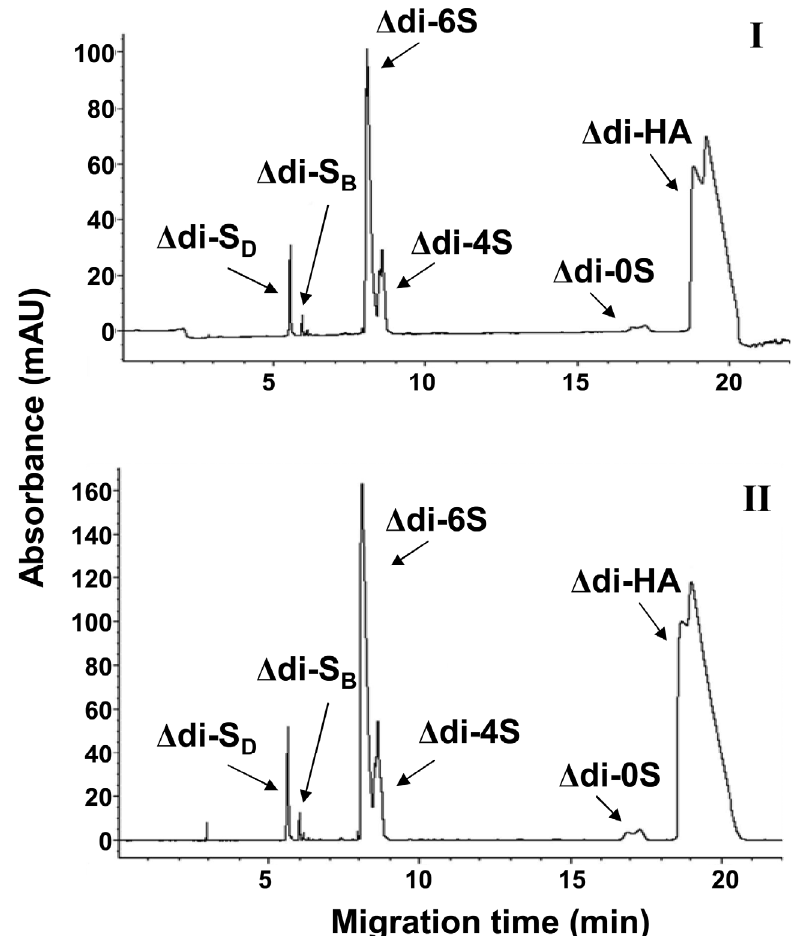
Figure 5. CE analysis of lens capsule from patients with cataract without XFS ( I ) and with XFS ( II ), both contained Viscoat ® . The analysis was performed by reverse polarity and the detection of Δ -disaccharide was at 230 nm. The operating buffer was 50 mM phosphate, pH 3.0. Lens capsule of a patient with XFS contains Δ di-S Δ di-0S and Δ di-HA